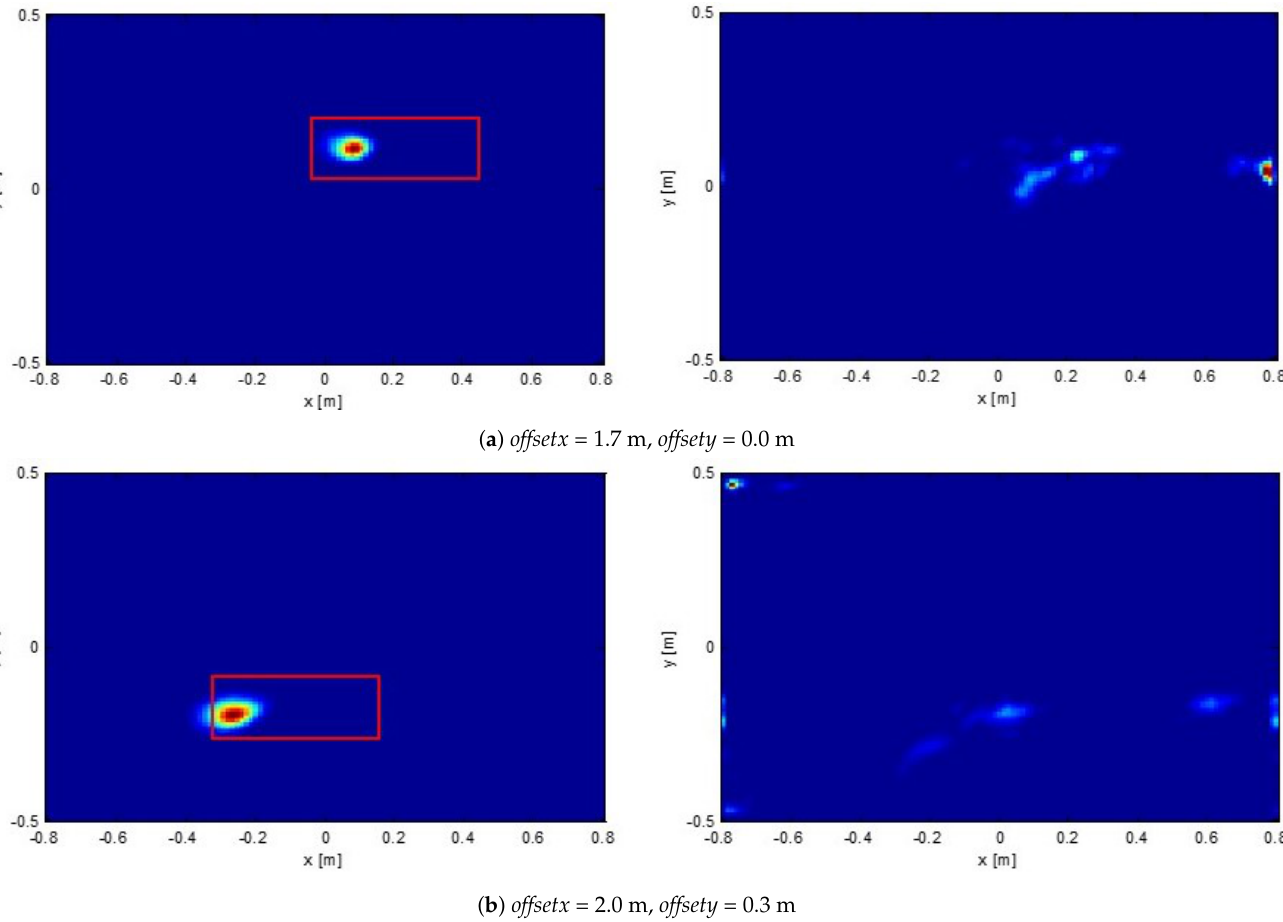
Figure 7. Normalized reconstructions of a shallowly buried targets for two different investigation domain offsets along with the actual target location denoted as red rectangles (figures un the left column). Normalized reconstructions background medium data, i.e., in absence of target, (figures on the right